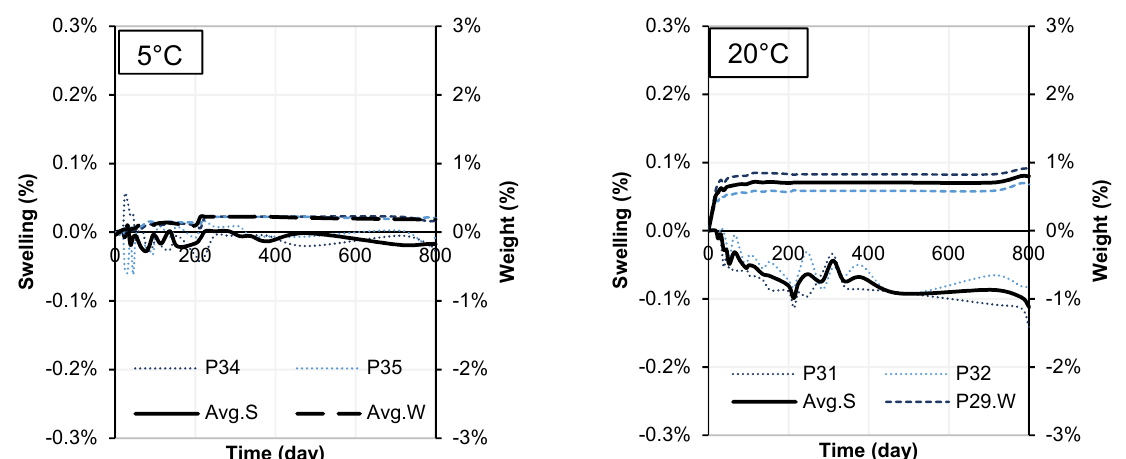
Figure 11. Swelling results in Sg + S + C + W2 at different temperatures.